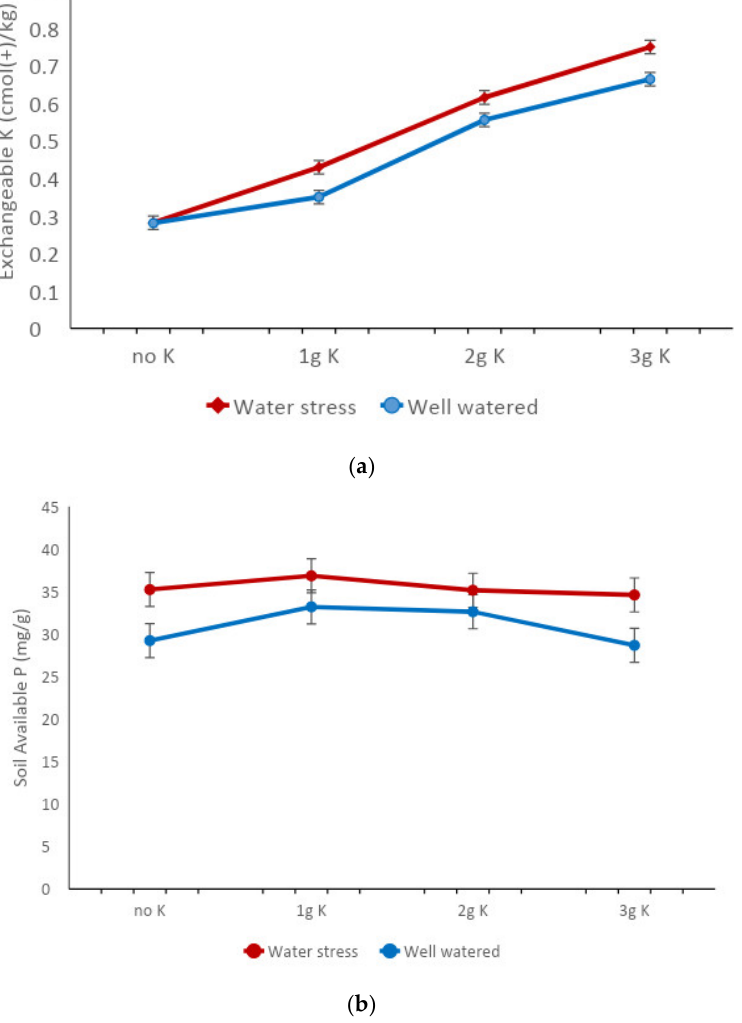
Figure 1. Soil contents of ( a ) exchangeable K, and ( b ) available P in well-watered and drought soils amended with various levels of potassium, after 55 days of irrigation treatment of cocoa seedlings grown in a gauzehouse facility. Bars represent the SED value to compare K levels at each water stress or well-watered